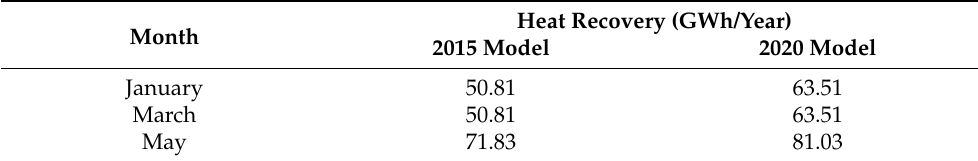
Figure 12. Root-mean-squared errors (RMSE) values for all models. Table 3. Annual potential heat recovery from the 2015 and 2020